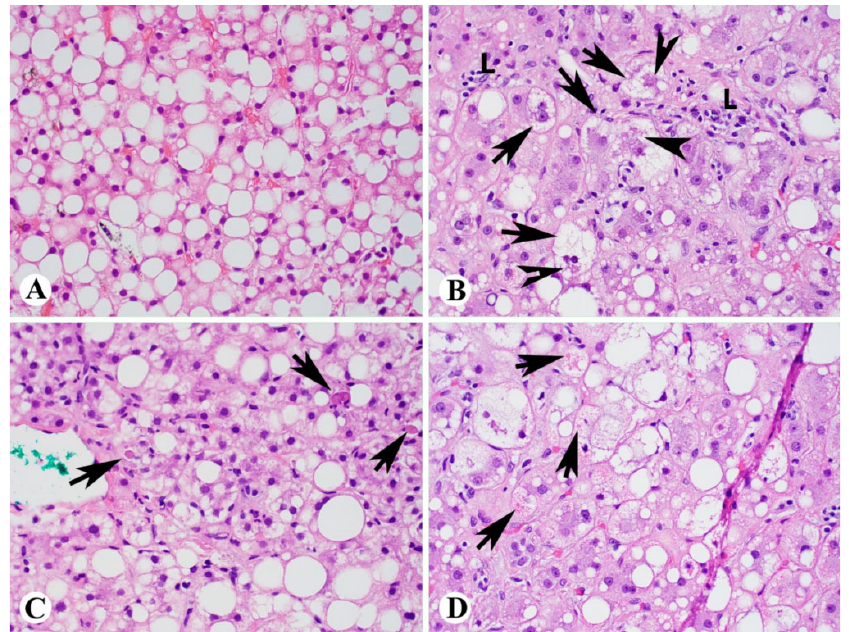
Figure 1. Histology of steatosis and steatohepatitis. ( A ): Macrovesicular steatosis; ( B – D ): steatohepatitis showing ballooned hepatocytes (arrows) with Mallory–Denk bodies (arrowheads), lobular inflammation (L), and mild perisinusoidal/pericellular fibrosis ( B ); acidophilic bodies/hepatocytes apoptosis (arrows) ( C ); and megamitochondria (arrows) ( D ) ( A – D , H&E stain, 400×).